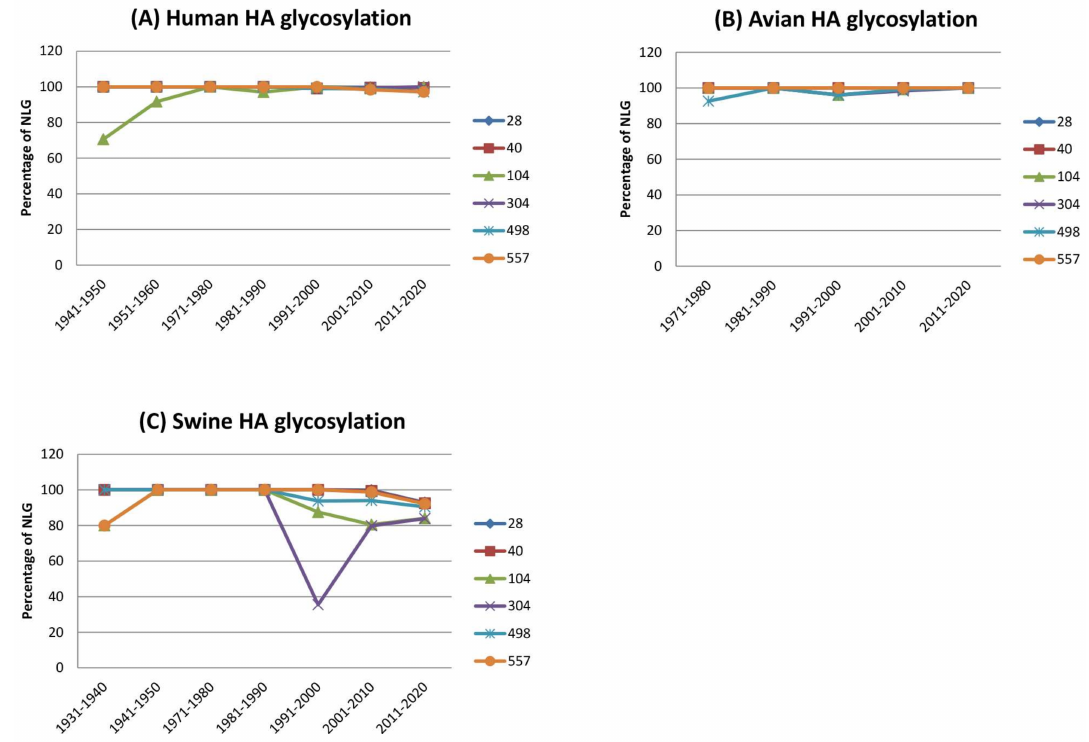
Figure 3. Conservation of N-linked glycosylation (NLG) sites of H1N1 HA per species. The six conserved HA NLG positions (28, 40, 104, 304, 498, and 557) of human ( A ), avian ( B ), and swine ( C ) isolates were analyzed for every decade from 1930 to present. The swine NLG position 304 was more variable than other